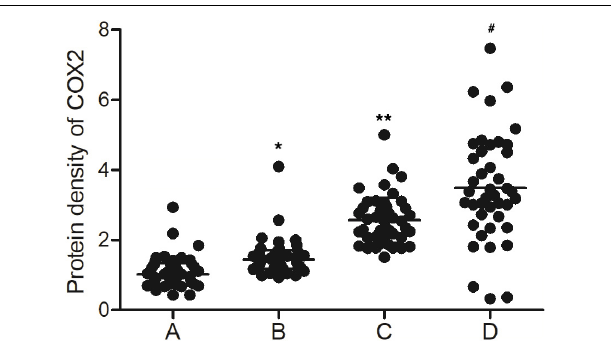
FIGURE 3 | The levels of COX2 protein were different among the MALAT1 HYPER + miR-146a HYPO group, MALAT1 HYPER + miR-146a HYPER group, MALAT1 HYPO + miR-146a HYPO group, and MALAT1 HYPO + miR-146a HYPER group (A: MALAT1 HYPER + miR-146a HYPO group; B: MALAT1 HYPER + miR-146a HYPER group; C: MALAT1 HYPO + miR-146a HYPO group; D: MALAT1 HYPO + miR-146a HYPER group. * p < 0.05 vs. group A; ** p < 0.05 vs. group B; # p < 0.05 vs. group C).